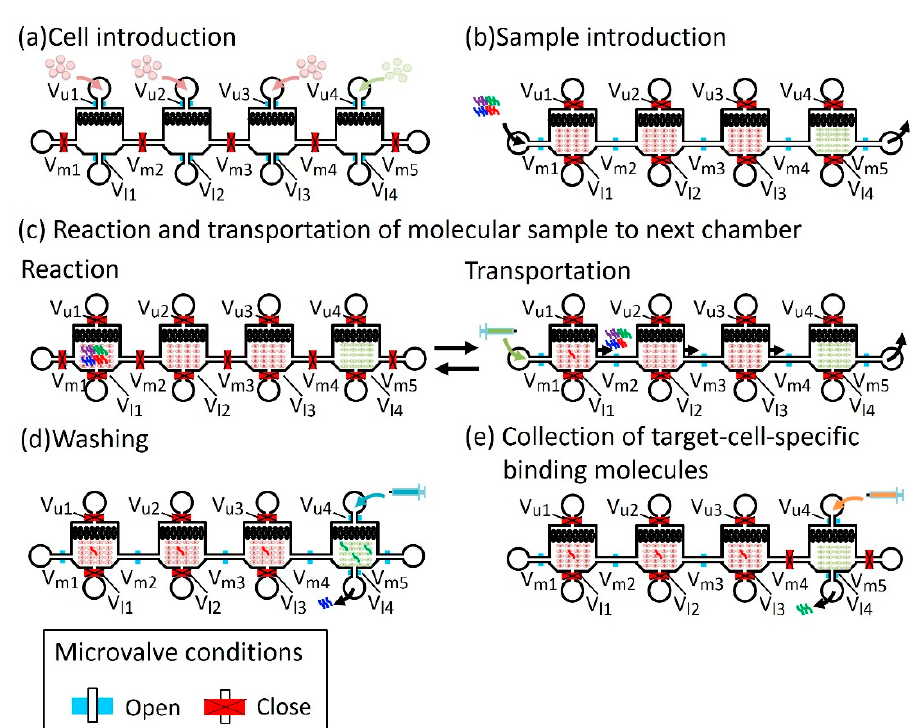
Figure 5. Operation of the microfluidic device to perform the screening procedure from step 1 to step 4. ( a ) Cell introduction. ( b ) Sample introduction. ( c ) Reaction and transportation of molecular sample to the next chamber. ( d ) Washing. ( e ) Collection of target-cell-specific binding molecules.